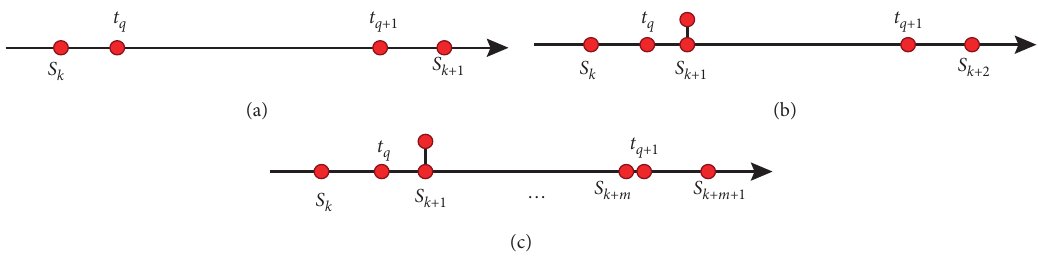
Figure 2: Moments of event triggering and system switching. (a) Case (i), (b) Case (ii), m � 1, (c) Case (ii), m >